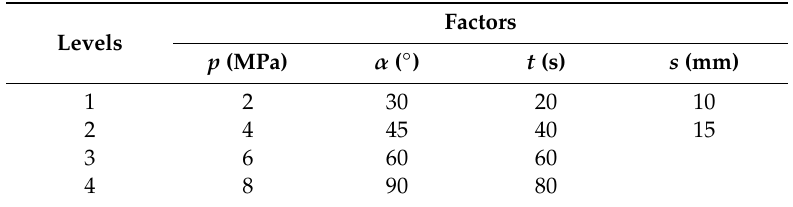
Figure 4. Erosion test parameters. ( a ) Erosion depth H (sectional view), ( b ) jet pressure p , jet angle α , stando ff distance s. Table 1. Factors and levels of orthogonal experimental design.